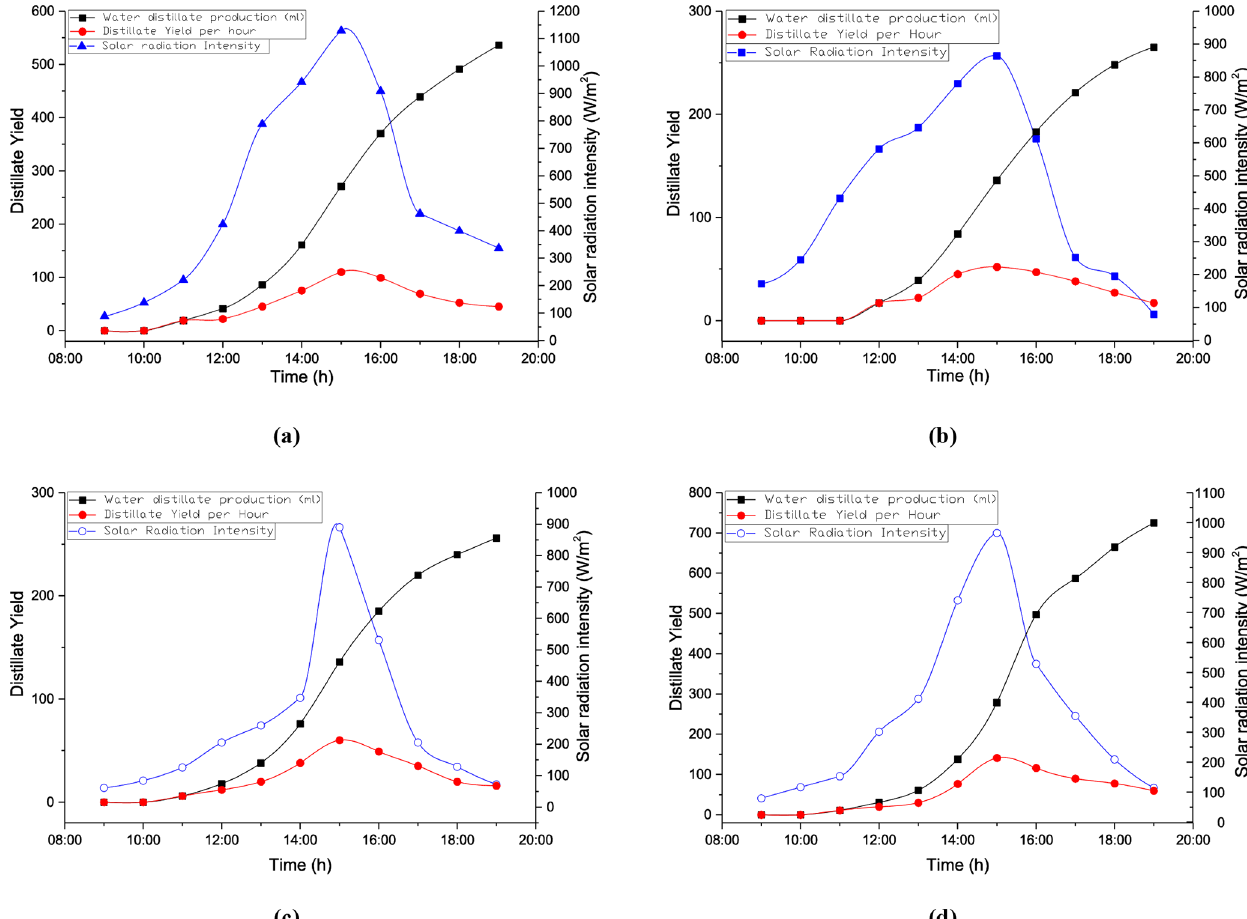
Figure 5. Influence of solar radiation intensity on the distillate yield. (a) Day 1, (b) day 3, (c) day 6, and (d) day 8.